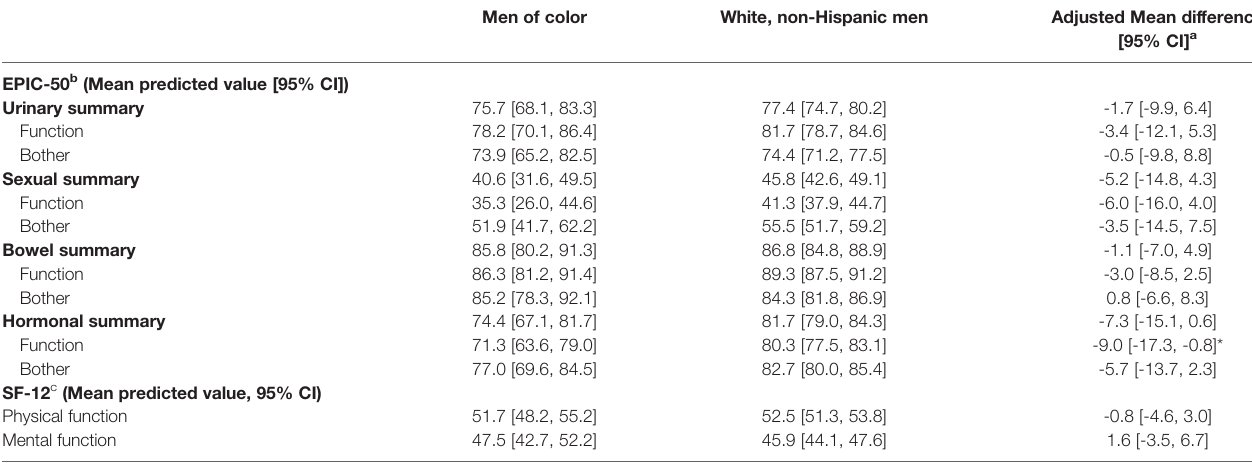
TABLE 4 | Adjusted Health-Related Quality of Life (HRQOL) outcomes for Sexual Minority Prostate Cancer Survivors by Racial and Ethnic Group (N=189). Men of